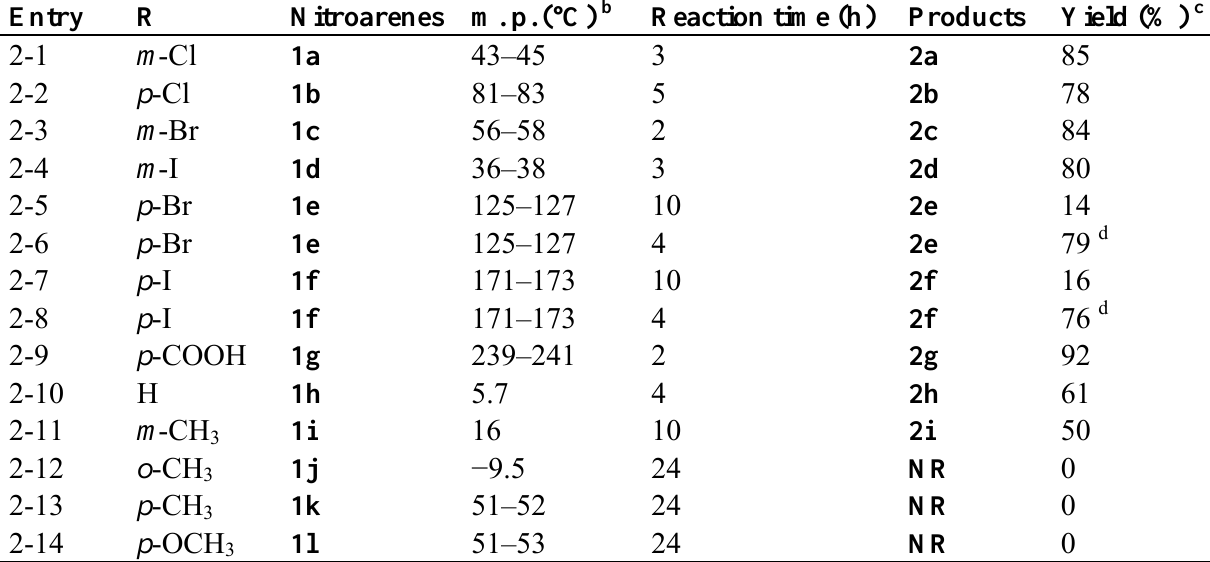
Table 2. Reductions of nitroarenes into the corresponding azoxybenzenes by potassium borohydride in water catalyzed by PEG-400 at refluxing temperature a